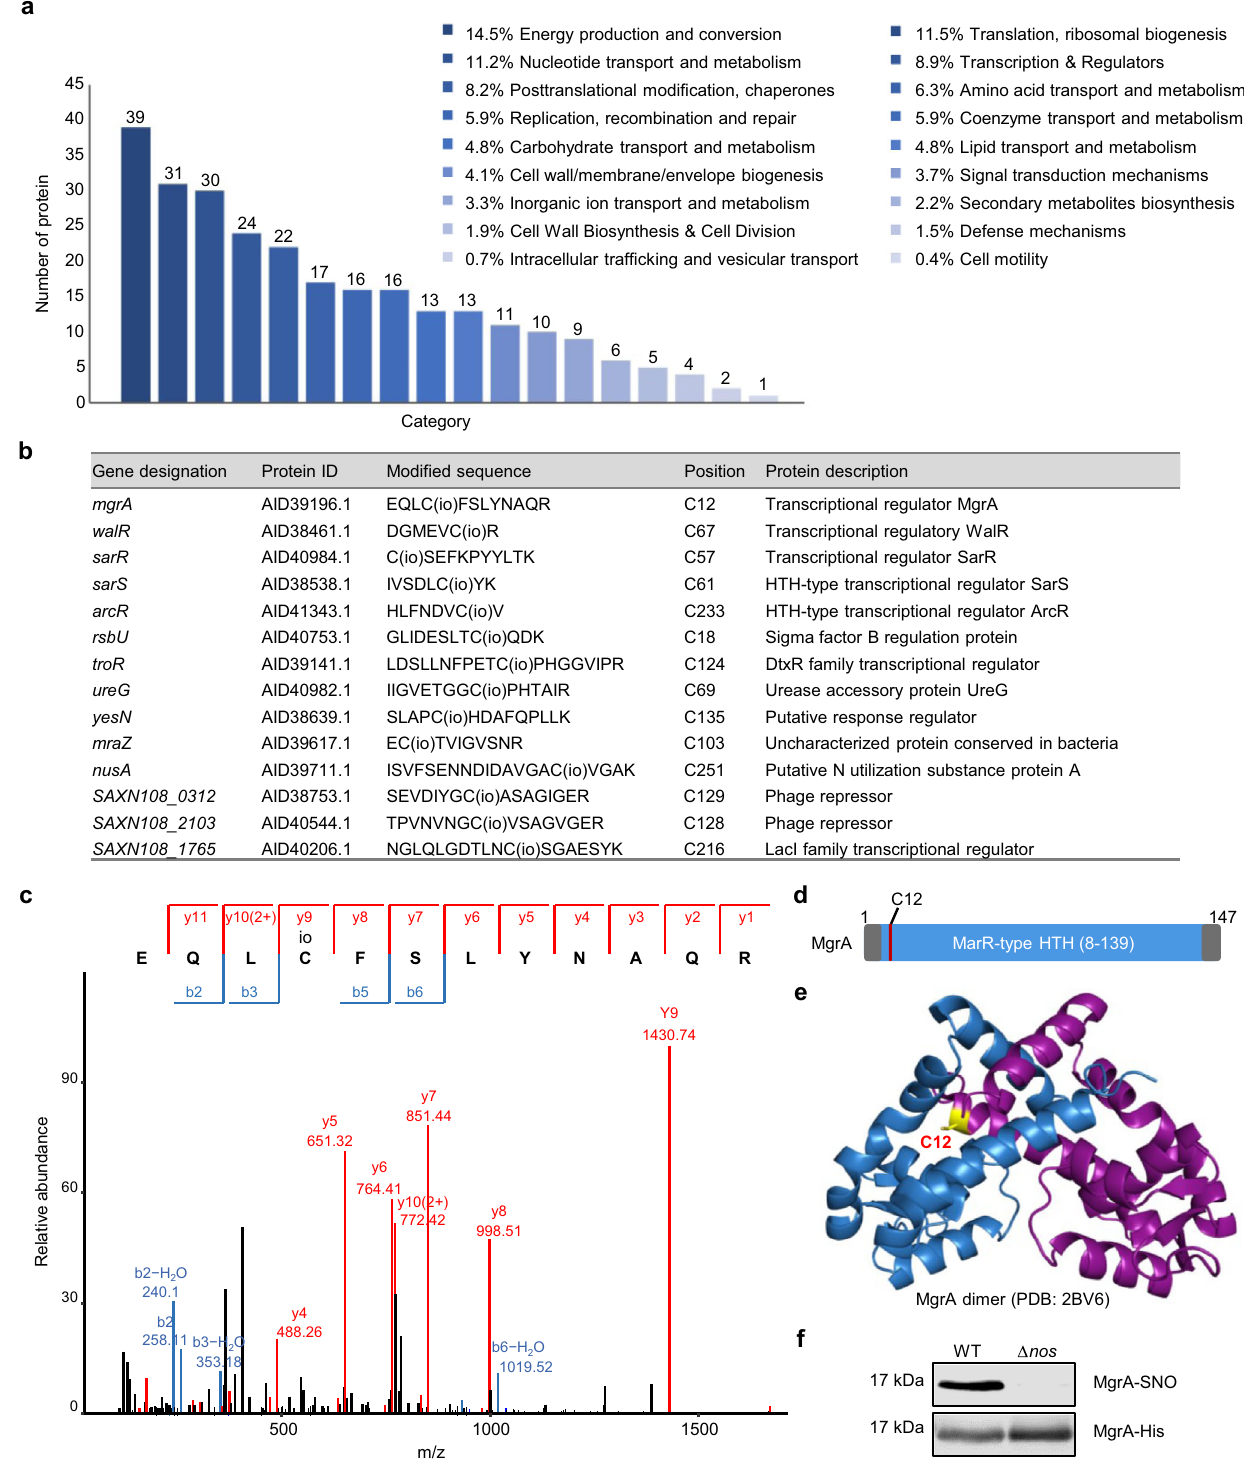
Fig. 1 | Identi fi cation of the transcription factor MgrA as a target of S-nitrosylation. a Summary of MS identi fi ed NO-modi fi ed proteins in S. aureus categorized by biological pathway. b Transcriptional regulators identi fi ed to be S-nitrosylated are listed. c Higher-energy collision dissociation mass spectrum of the cystine 12-containing peptide from MgrA. S-nitrosylated cysteine was labeled with isobaric iodoTMT and marked with io. The cysteine residue Cys12 of MgrA is